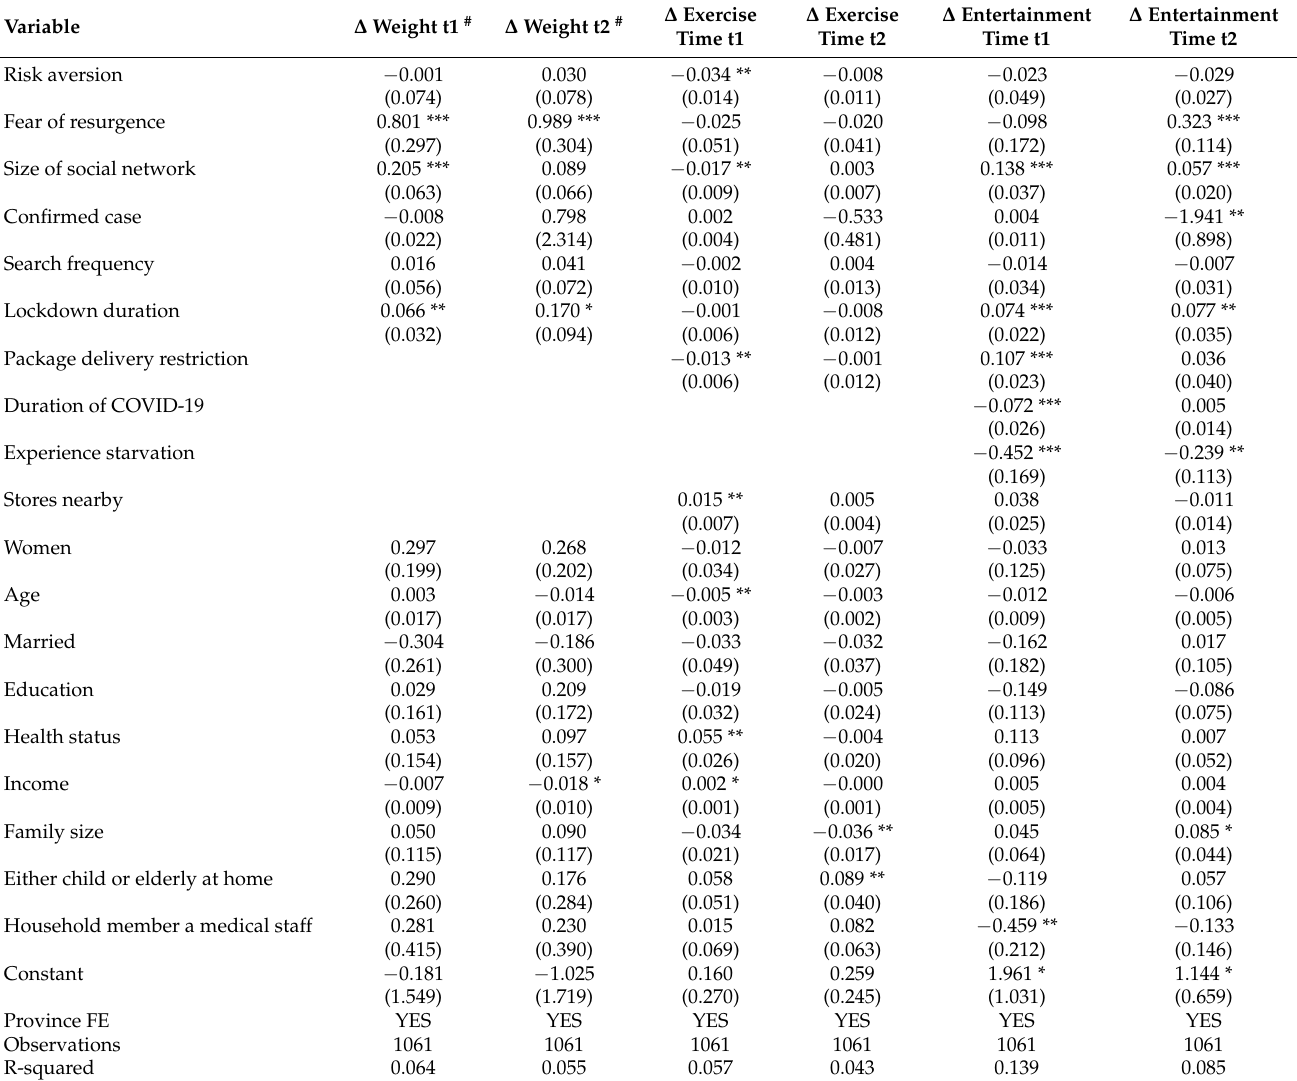
Table 2. Empirical results for bodyweights and time